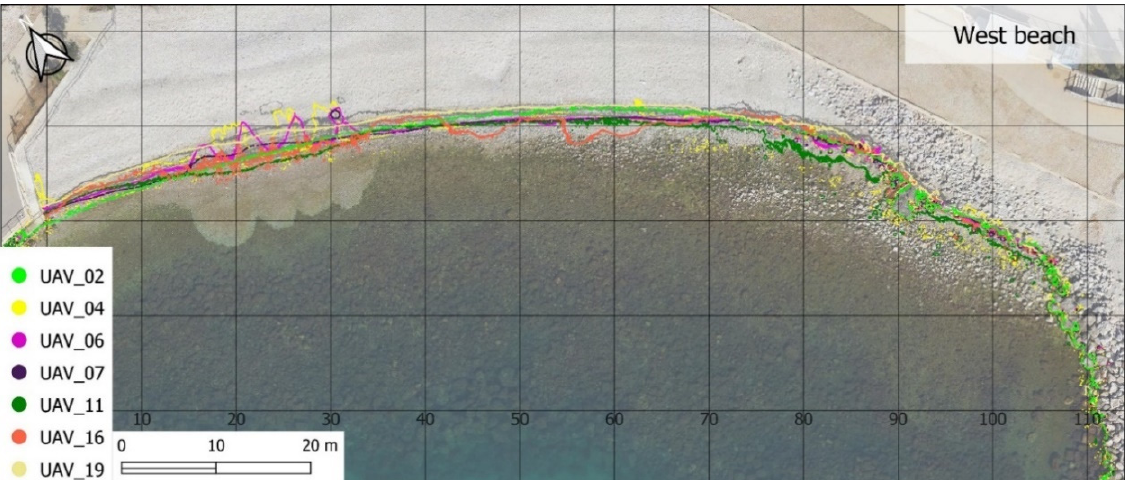
Figure 8. Shoreline